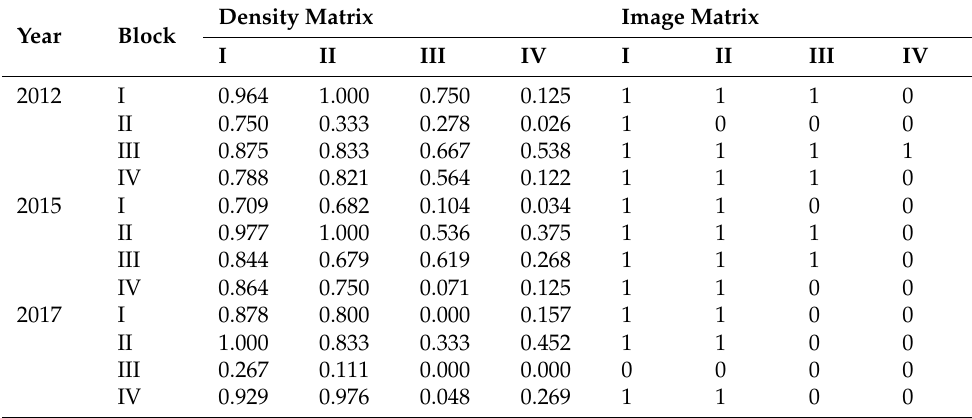
Table 4. Density matrix and image matrix of blocks in ECETN.